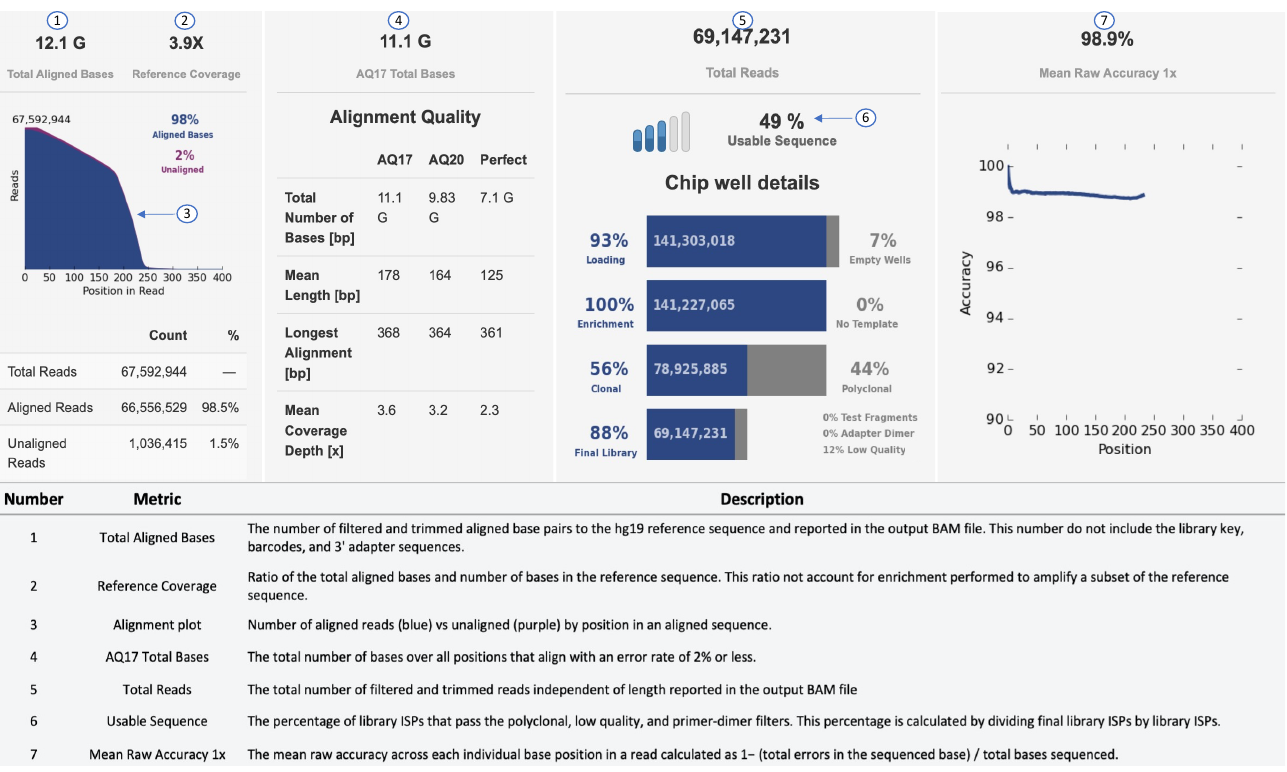
Figure 3. Sequencing performance of Ion Torrent. Metrics, such as Raw Accuracy, Aligned Bases, and Total Reads, can be used to determine the performance of a run.